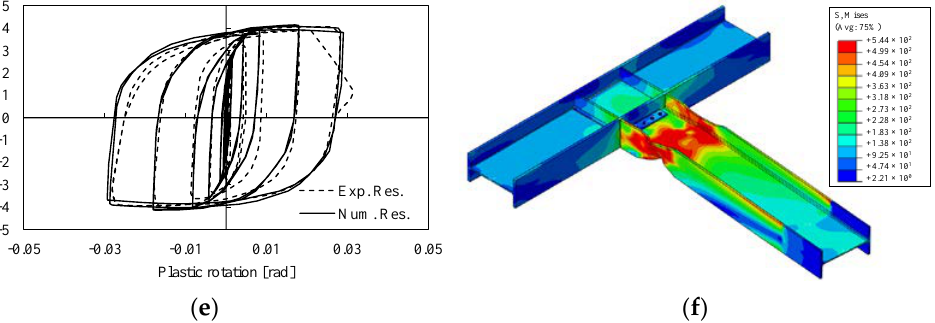
Figure 6. Comparison between the experimental [8] and numerical results in terms of moment– plastic rotation curves ( a , c , e ) and damage pattern ( b , d , f ) for all considered specimens tested in [8].